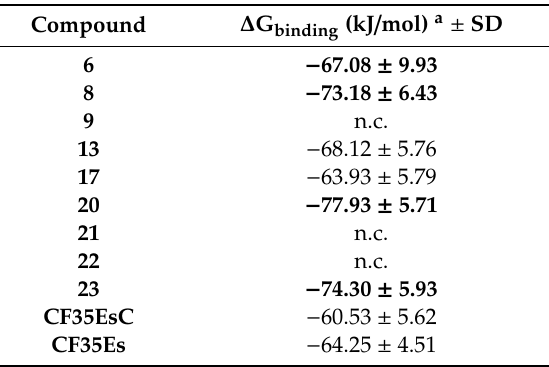
Table 1. Calculated ligand interaction energies for the compounds analysed after the molecular dynamic